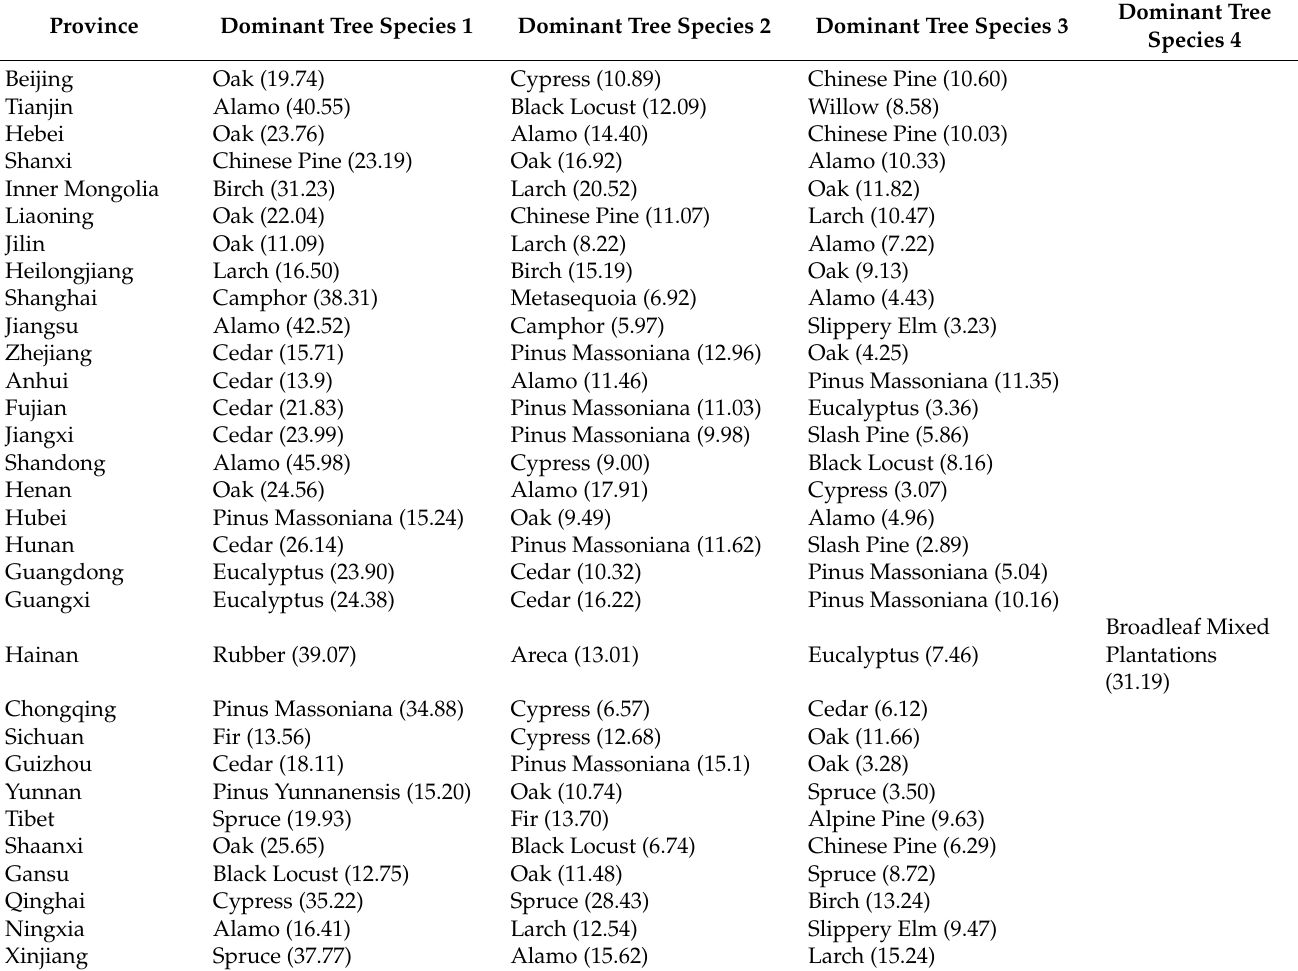
Table 2. Dominant tree species and area proportion (%) in each region of